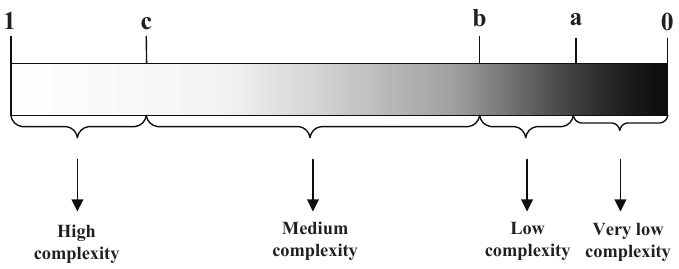
Figure 8. Mapping relationship between the saliency range and complexity